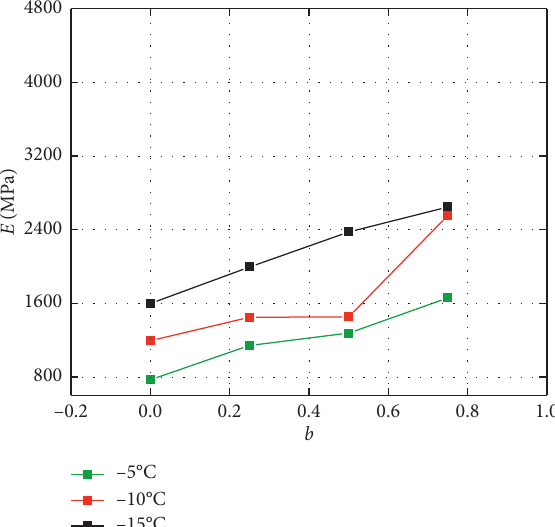
Figure 9: The relationship between the elastic modulus E and the temperature T and the intermediate principal stress coefficient b .